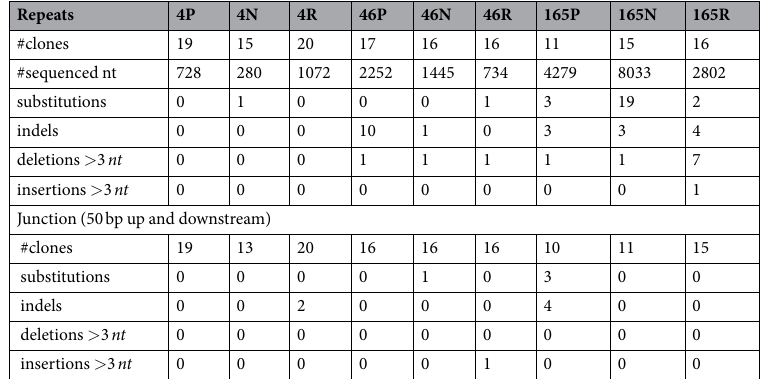
Table 1. Fidelity of the assembly process. Number of substitutions, indels, insertions and deletions measured from sequencing 145 clones covering the 9 different repeat designs tested of 4, 46 and 165 bp. P stands for GC Poor, N for G/C Neutral and R for G/C rich. Sequences used to create this table are given in Supplementary Figs